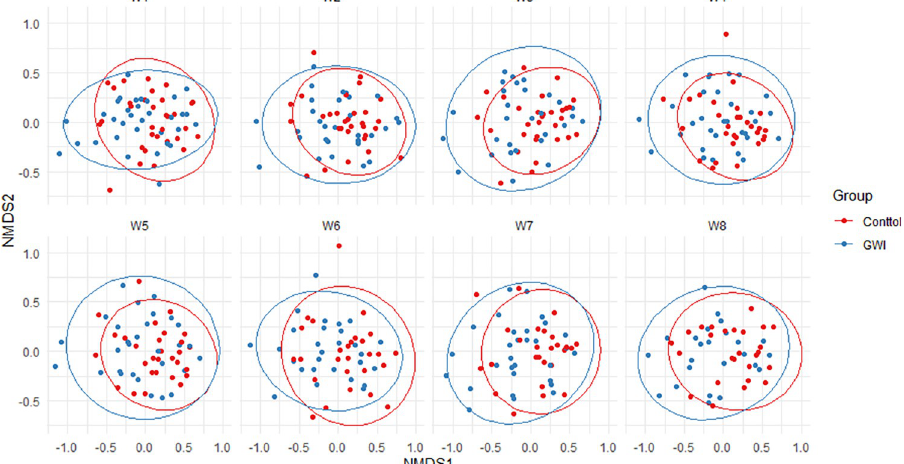
Fig 5. NMDS plot of the Bray-Curtis dissimilarity matrix by week and GWI